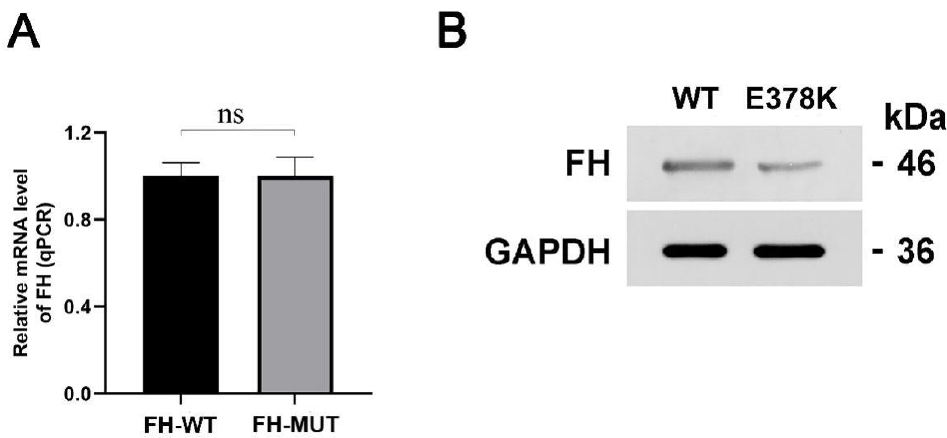
Figure 9. mRNA transcription ( A ) and FH enzyme expression ( B ) affected by E378K